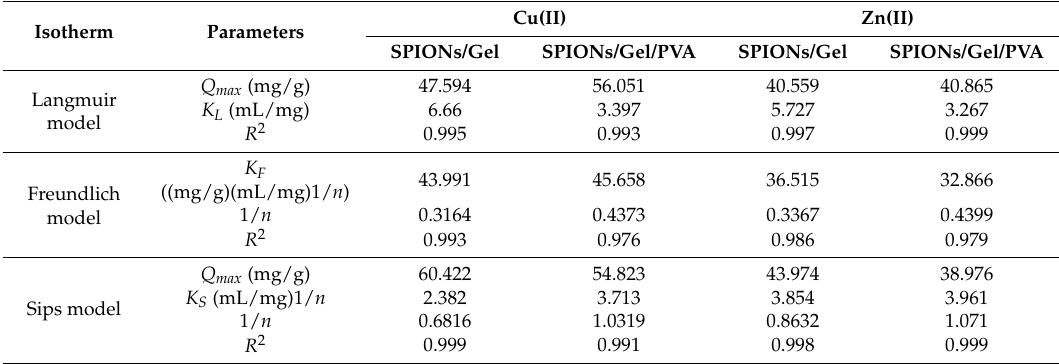
Table 2. Fitted result of the adsorption isotherms of the Cu(II) and Zn(II) by SPIONs/gel and